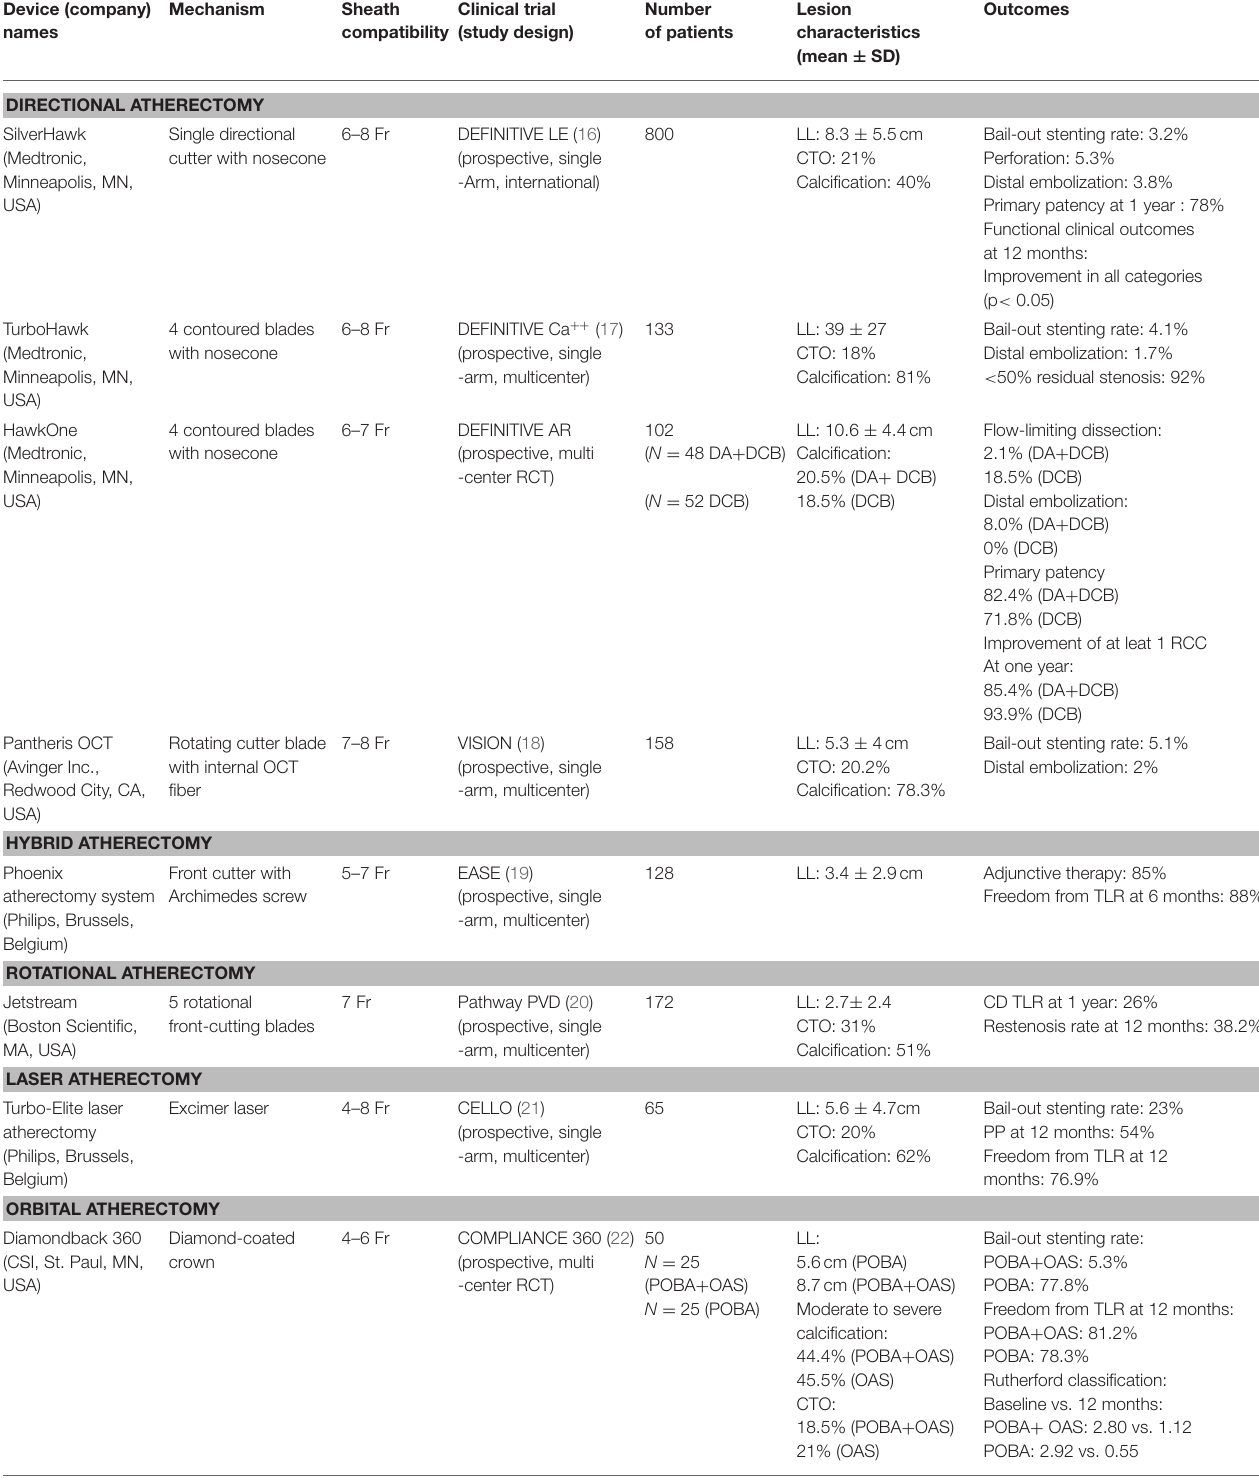
TABLE 1 | Atherectomy